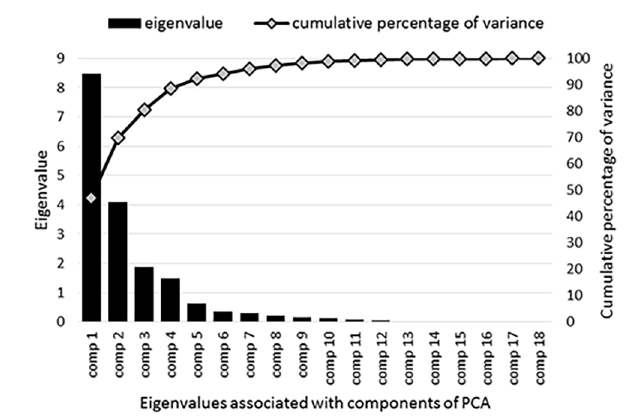
Fig. 3. Bar plot of the eigenvalues showing the number of components significant for interpretation. In the present dataset, the first four components account for 88.66% of